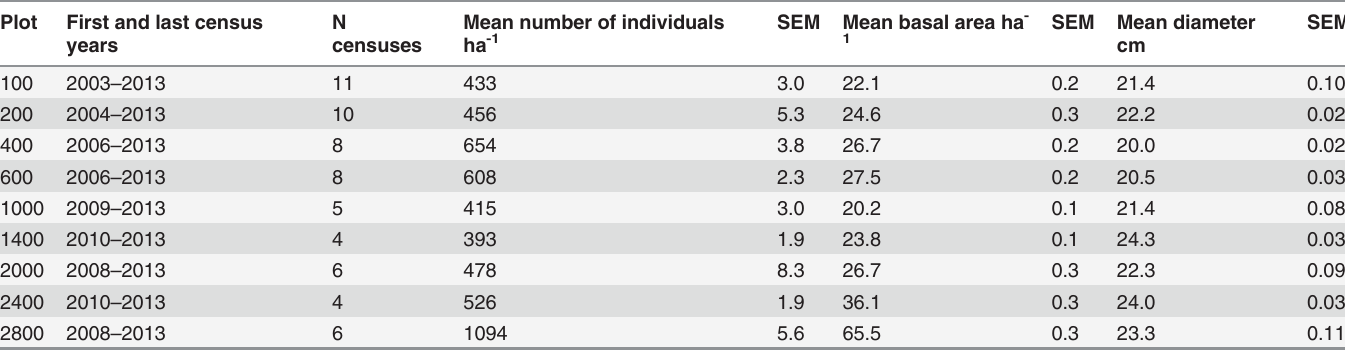
The number of individuals, plot basal area, and average stem size in 1-ha old-growth plots over an elevational transect on Volcán Barva, Costa Rica. Plots were censused annually. SEM = one standard error of the